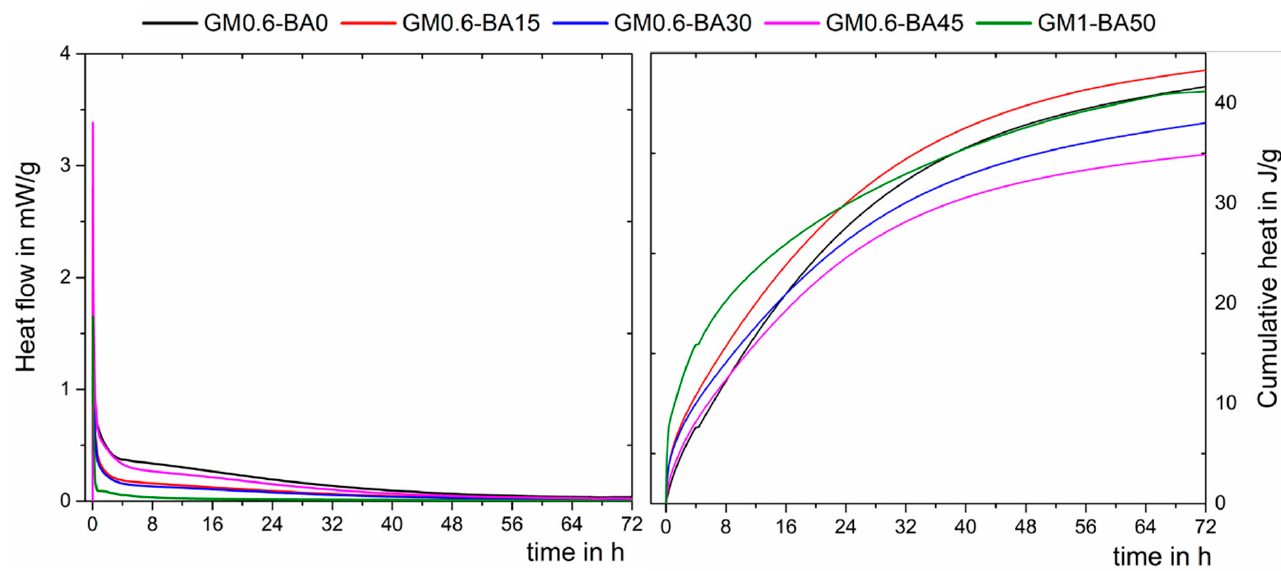
Figure 8. Heat evolution of AA paste samples at 20 °C.